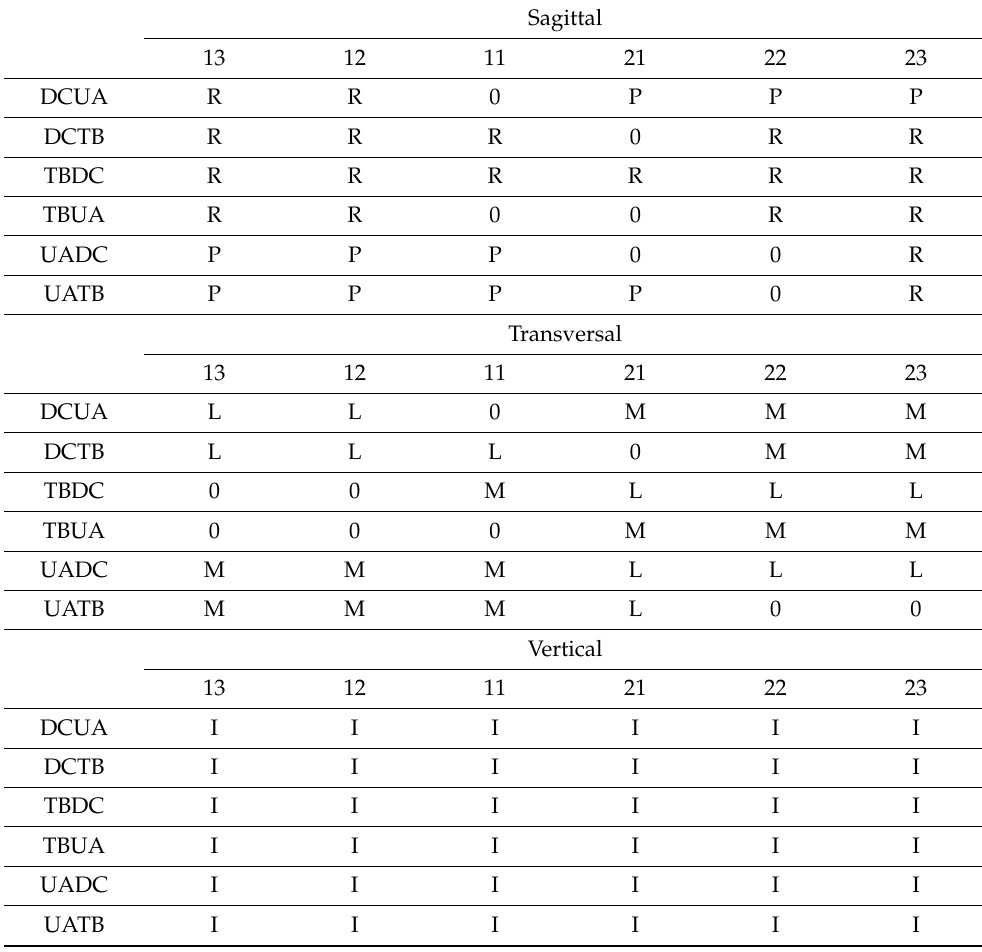
Figure 4. Asymmetric activation of 10 mm DCUA (T0: red, T1: green). Table 2. Asymmetric activation of cantilevers (R — retrusion, P — protrusion, I — intrusion, M — medial displacement, L — lateral displacement, 0 — no change).